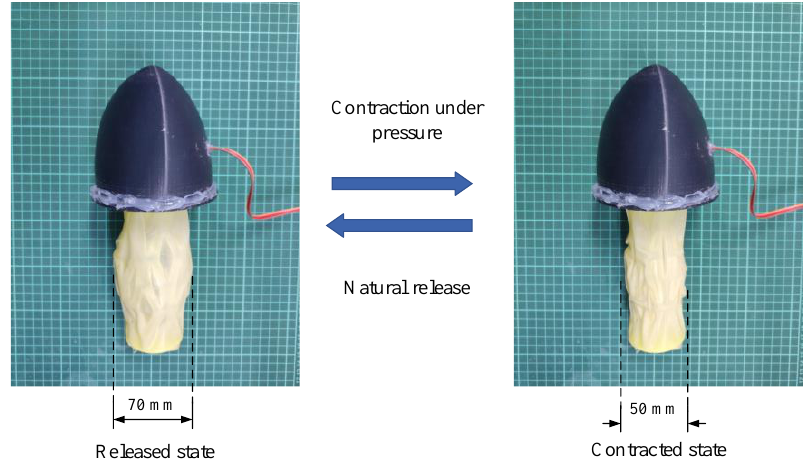
Figure 17. Morphological changes of origami flexiball inspired bionic jellyfish.